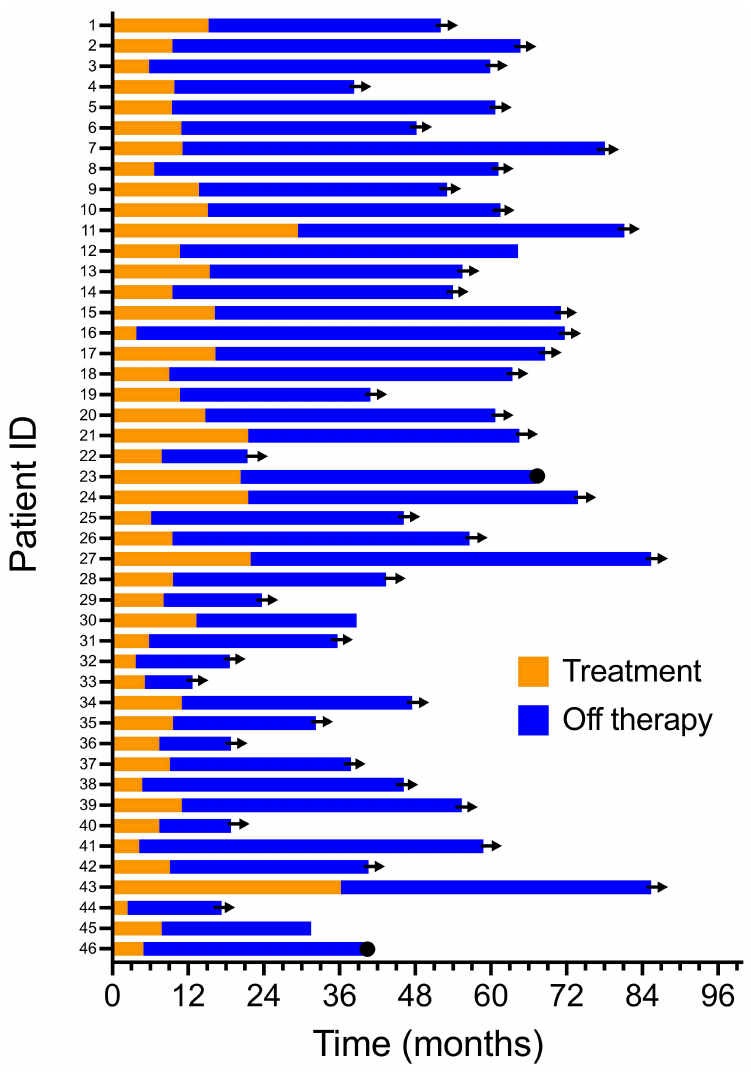
Figure 3. Swim-lane plot of duration of initial and second line